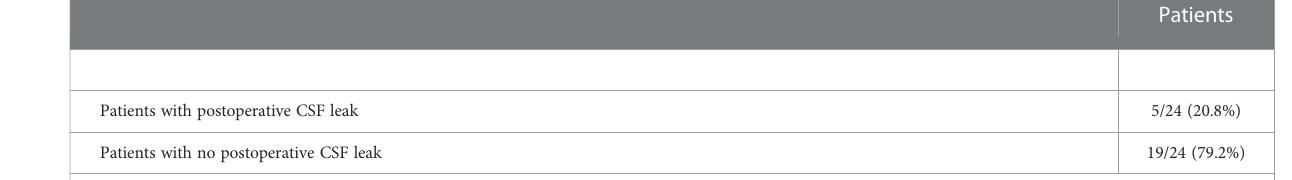
Patients with postoperative CSF leak Patients with no postoperative CSF